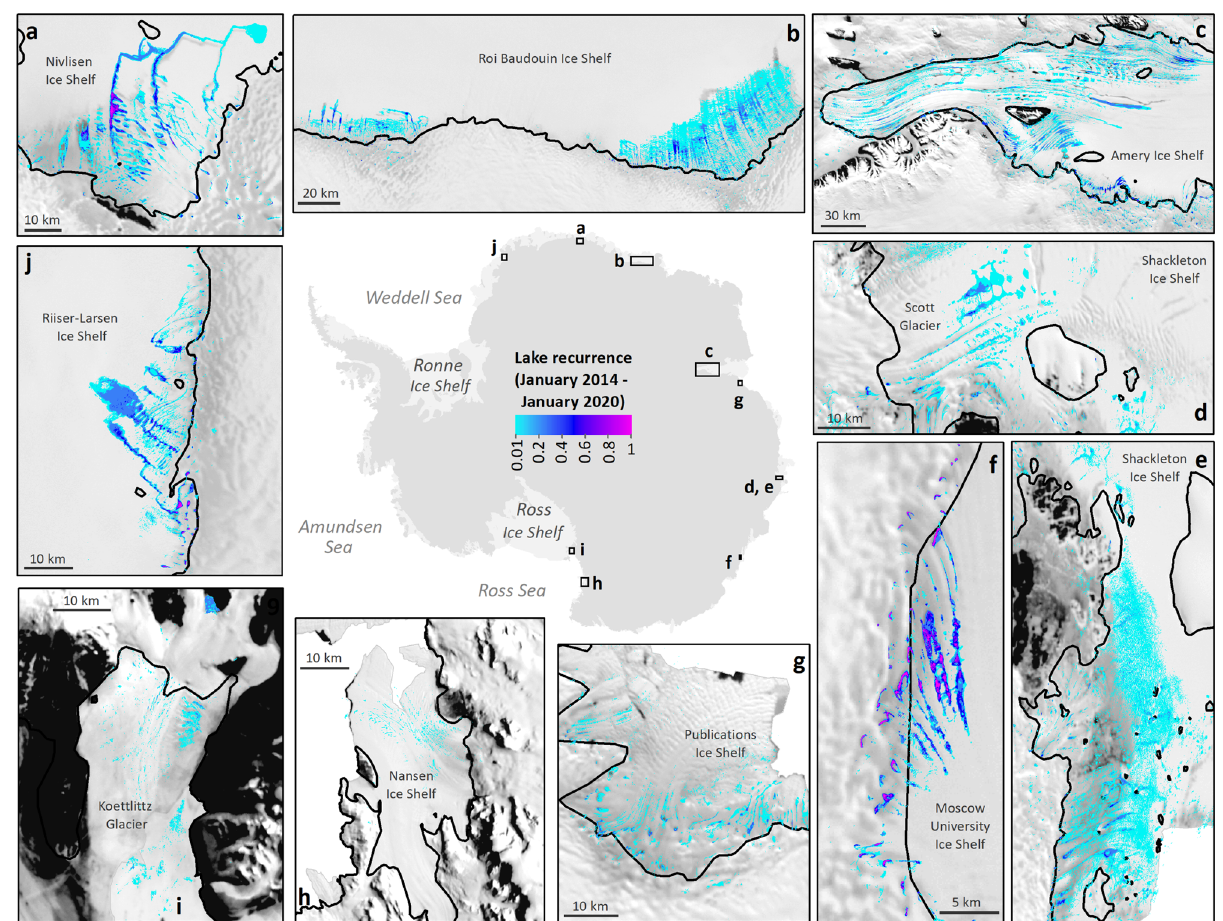
Fig. 3 Supraglacial lake recurrence around East Antarctica. ( a – j ) Normalised count of overlapping lakes at their maximum extent during January from 2014 to 2020 on selected major ice shelves and outlet glaciers, weighted according to the number of useable (partially or totally cloud-free) satellite images in this period. Turquoise/pale blue colours correspond to infrequently-forming lakes (i.e. that formed in a single year) and pink/purple colours correspond to frequently-forming lakes (i.e. that formed on multiple dates in January in several or all years). This fi gure highlights the distribution of SGLs across these major ice shelves but note that lakes occur with less frequency in other regions, for example along the Ingrid Christensen Coast (between Polarbroken Glacier and Shackleton Ice Shelf) and on Voyeykov Ice Shelf (adjacent to Moscow University Ice Shelf). The grounding line is shown as a solid black line in all panels. Grounding line from ref. 77 and coastline from ref. 78